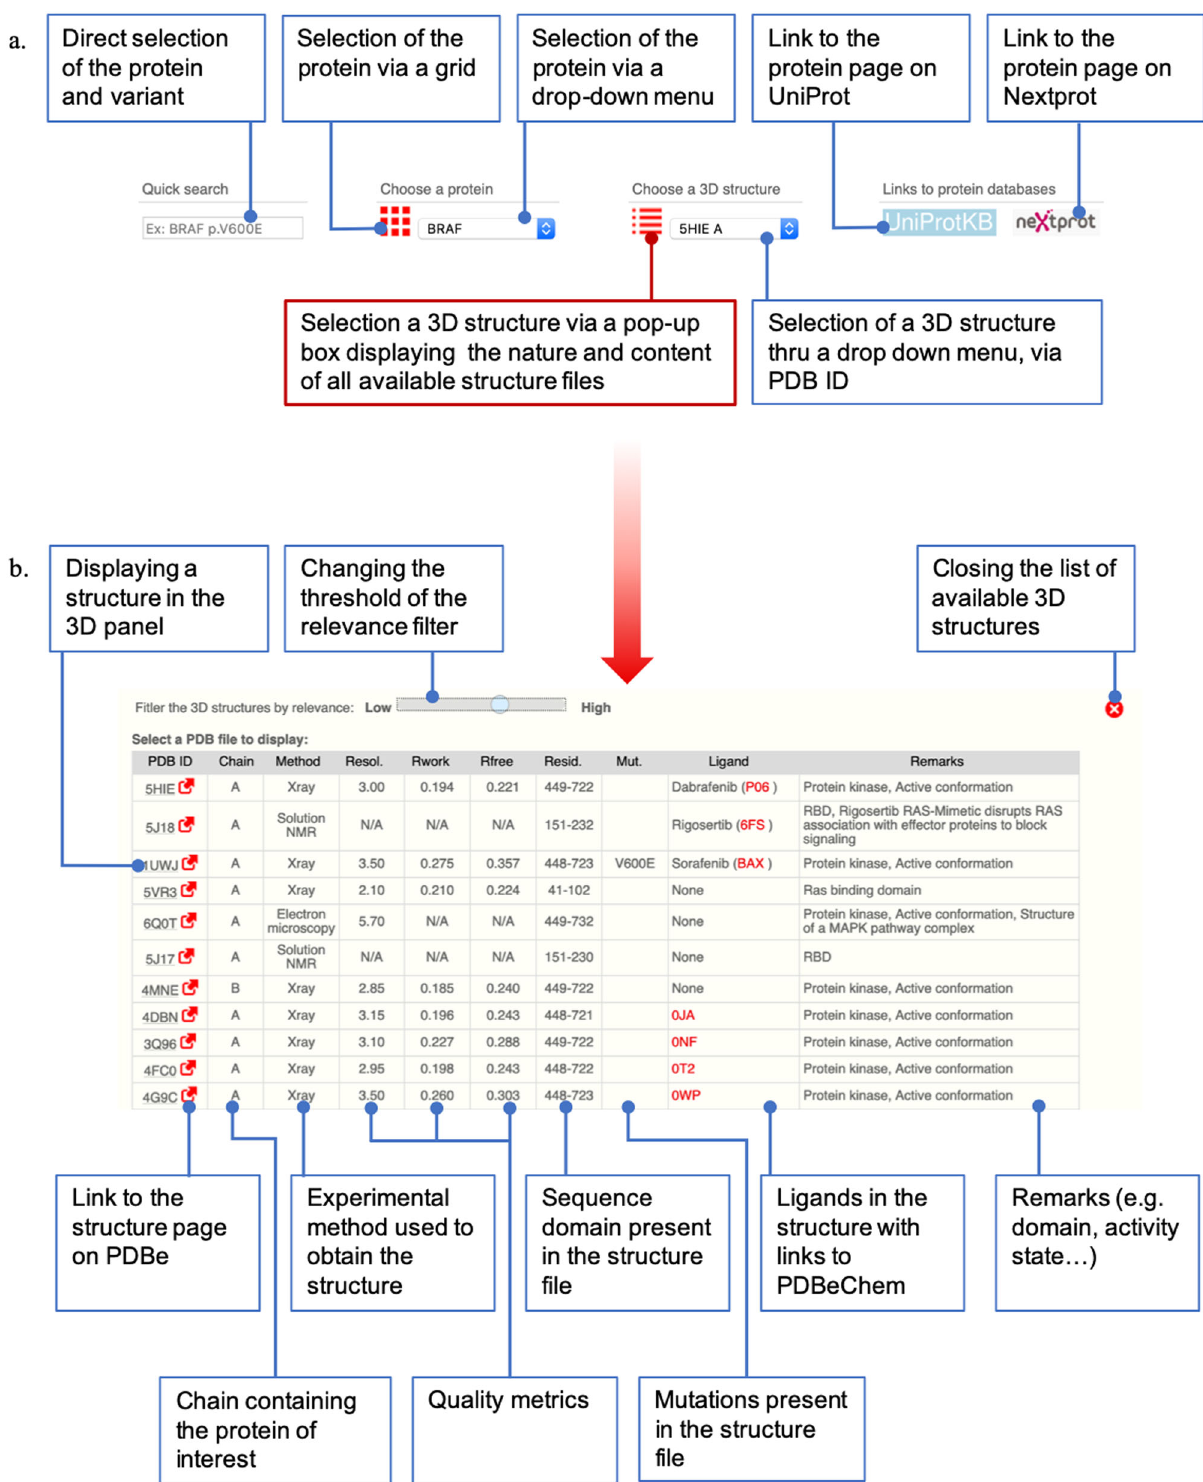
Fig. 3 The selection panel. a Description of the selection panel. b Description of the structure list table. selected, the most relevant structure, as determined by the score described above and Supplementary Table 5, is automatically displayed by default in the 3D-structure panel. Users can display other structures. The latter can be selected from a drop-down menu introduced for advanced users who already know which 3D structure they would like to display and want to pick it rapidly.